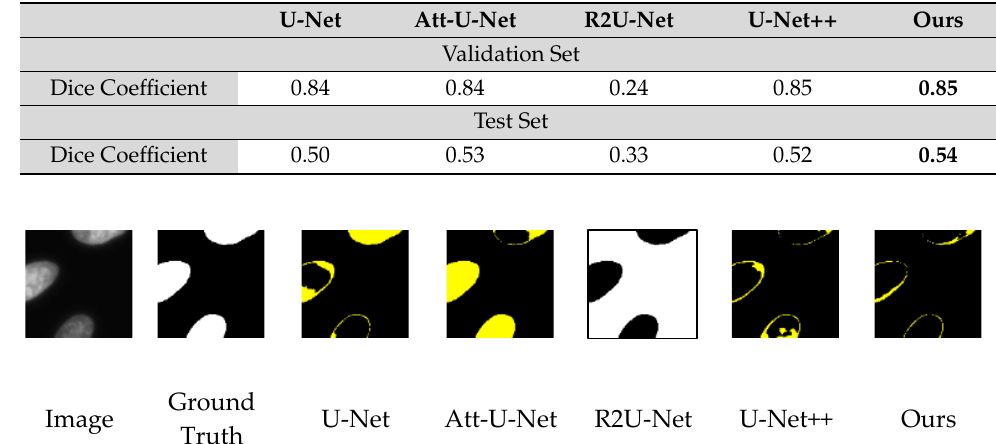
Figure 8. The segmentation results using different models with the C3S during the training phase for the same image in Figure 7. Table 3. Ablation experiments on the segmentation network.